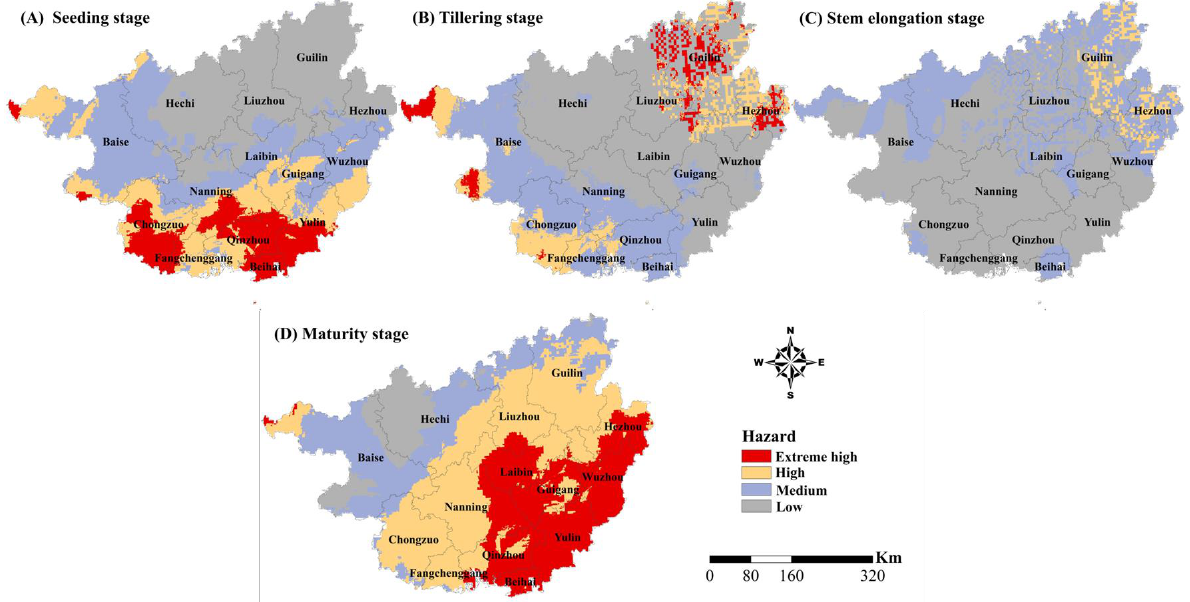
Figure 6. Spatial changes in the drought hazard levels of the four growth stages of sugarcane in Guangxi; ( A – D ) represent the stages of seedling, tillering, stem elongation, and maturity, respec-